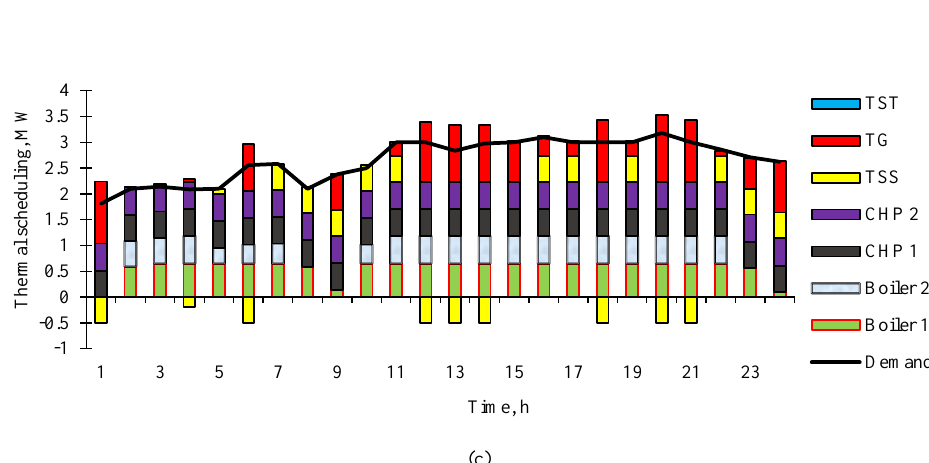
Fig. 8. (a) Selection of best solution in Non-dominated solutions in Case II, (b) Electrical power generated in Case II and (c) Thermal power generated in Case